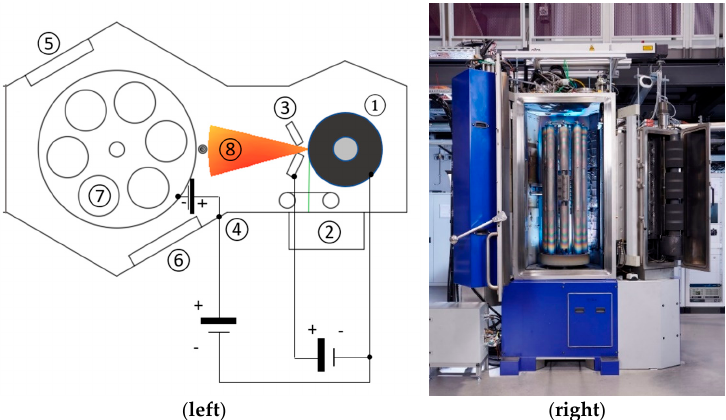
Figure 2. Scheme of the coating device DREVA 1200 ( left ): (1) cathode; (2) laser scanning system; (3) two-part anode; (4) bias supply; (5) radiation heater; (6) magnetron sputtering source; (7) substrate holder and rotation; (8) plasma; and coating chamber with Laser-Arc Module TM LAM500 ( right ). Photo by ©Jürgen Jeibmann, Dresden, Germany.